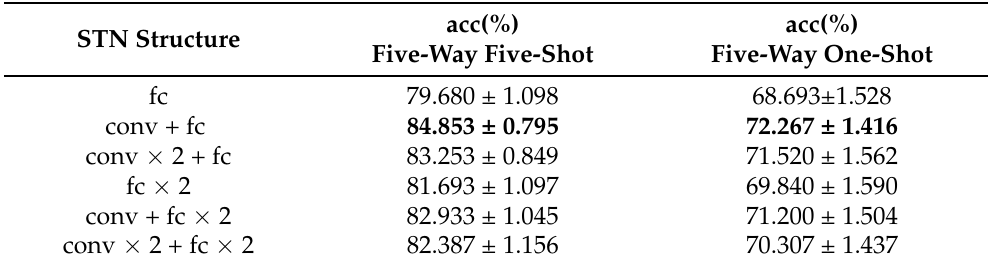
Table 5. Experiments on the structure of localization network. Note that fc denotes a fully connected layer, and conv denotes a convolutional layer with a max-pooling layer and a ReLU function following behind. Bold numbers indicate the best results.